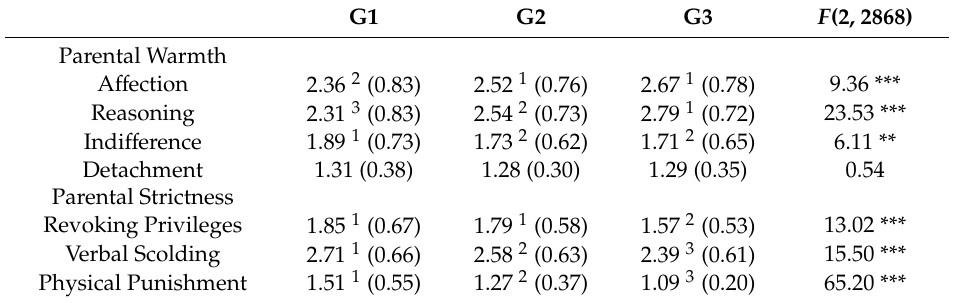
Table 2. Means and (standard deviations) in parental practices of warmth and strictness across generations.